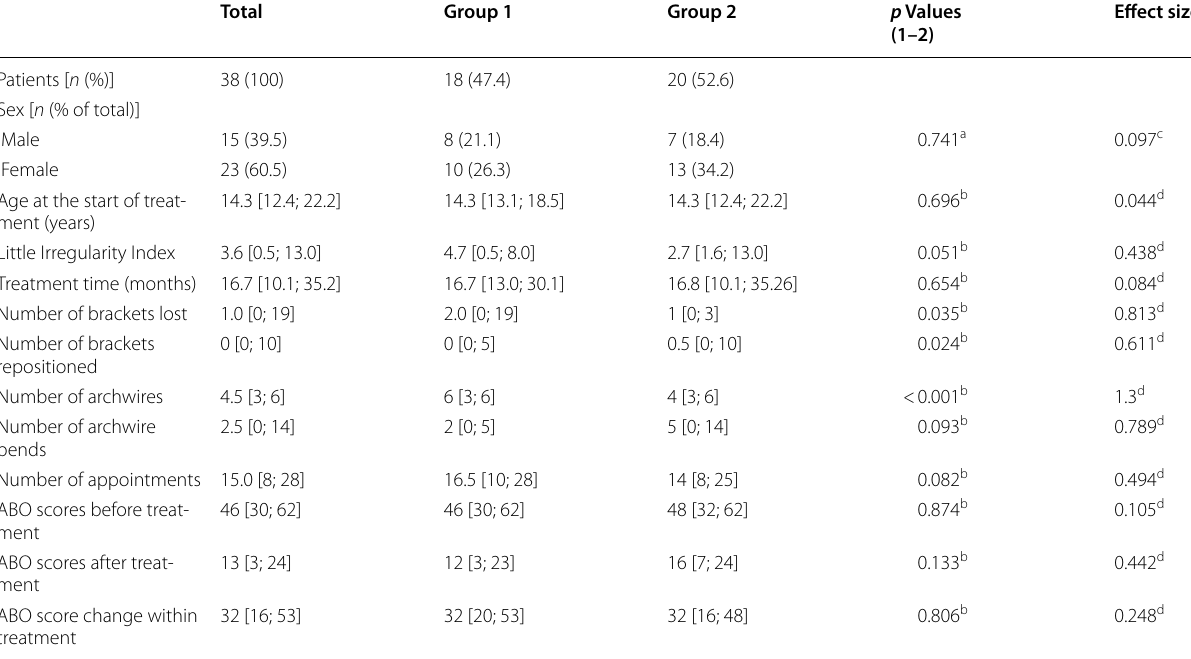
Table 1 Descriptive statistics of conditions during therapy including ABO